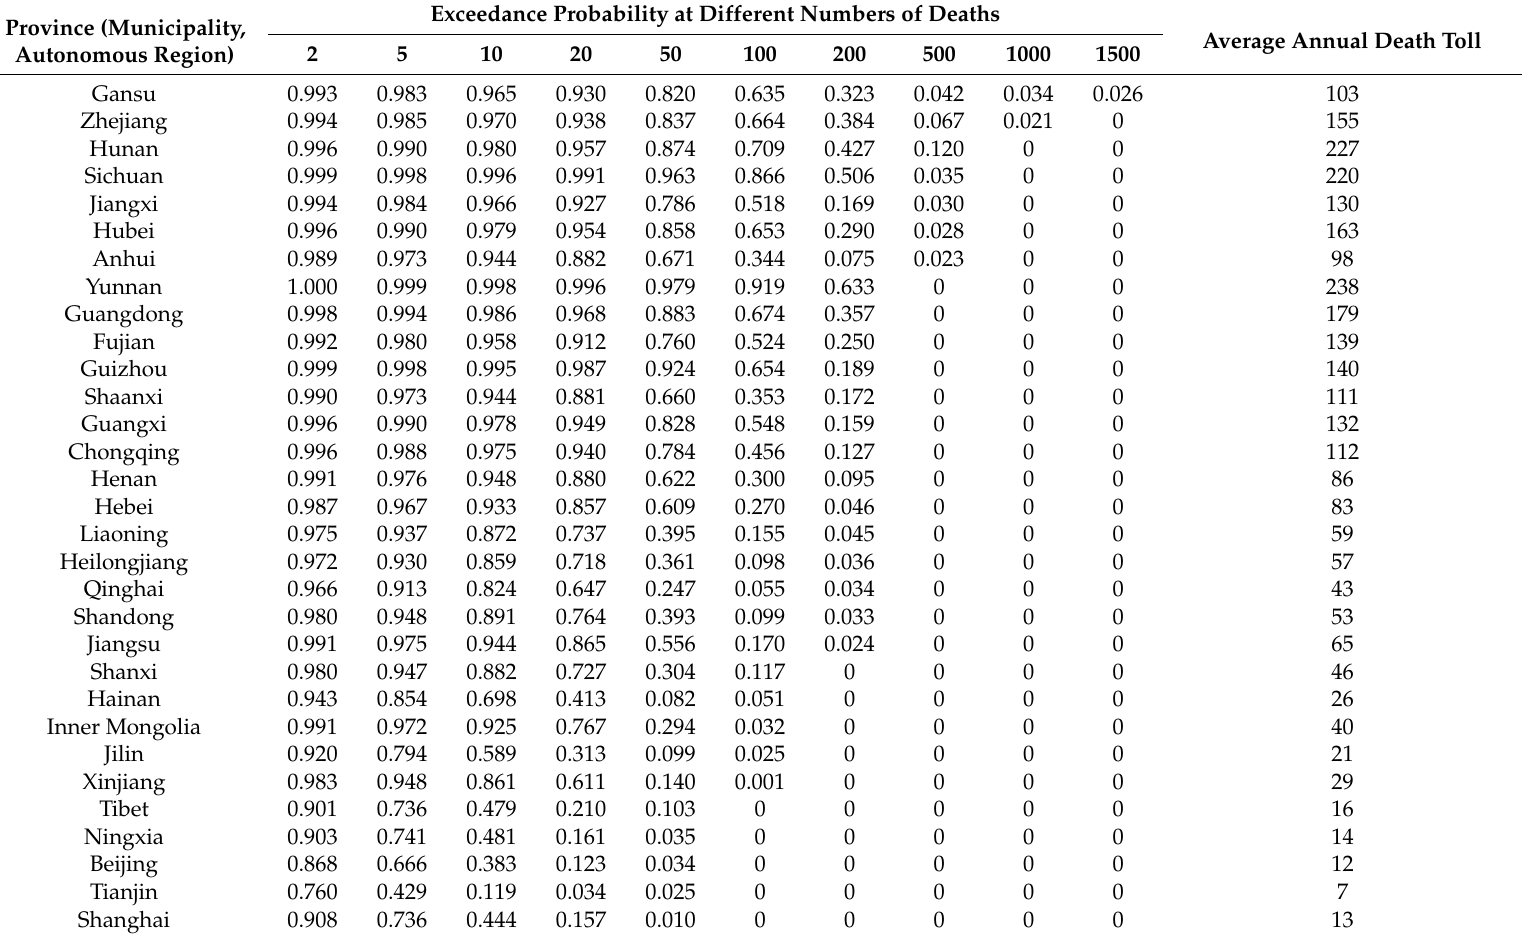
Table 2. Exceedance probability for a given number of deaths for each province (municipality, autonomous region) in China. Province (Municipality, Autonomous Region)